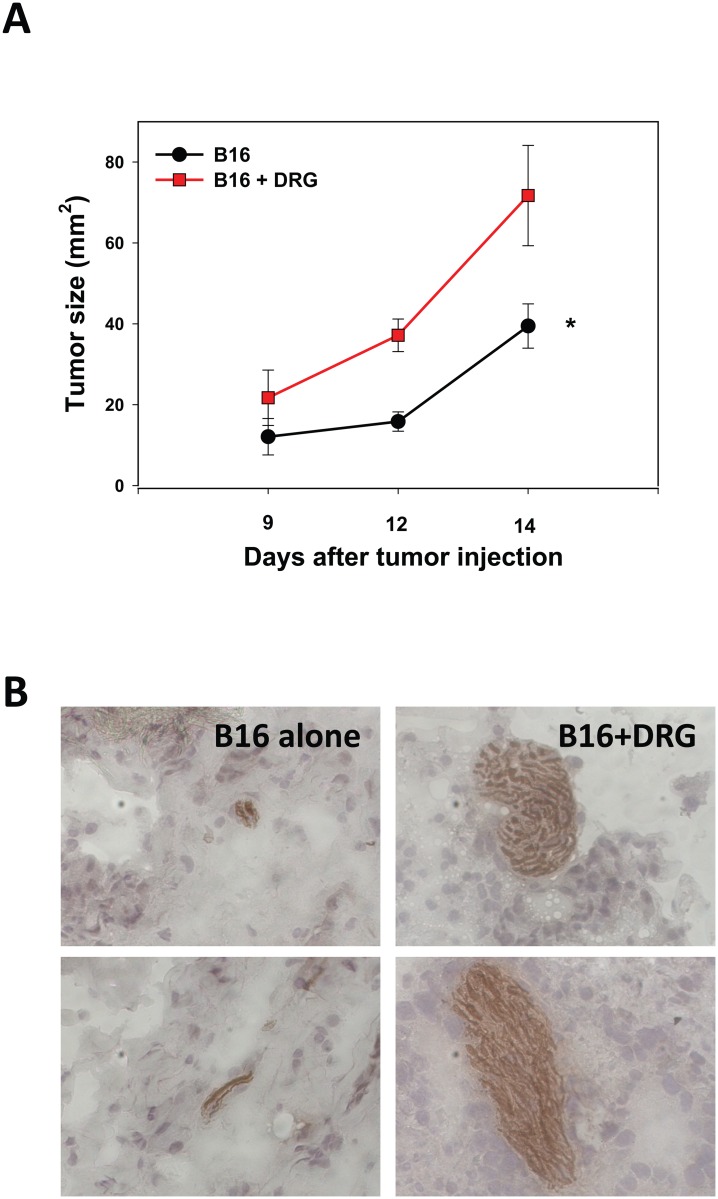
Co-administration of DRG neurons with B16 melanoma cells up-regulated tumor growth in mice.C57BL/6 mice (5 mice/group) received s.c. injection of 50x103 tumor cells alone or mixed with cultured DRG neurons (1:5 cell:cell ratio). Tumor size was assessed using a caliper and expressed in mm2 (A). Administration of DRG cells alone, as expected, did not induce any tumor growth. Tumor tissues were harvested two weeks later, and the presence of live DRG neurons in the tumor was determined by DAB staining after 14 days using an antibody against the anti-Neurofilament H epitope (B). Left panels show control tumors (administration of B16 cell alone), right panels show tumors growing in mice receiving B16+DRG neurons injections. Tumor size is expressed as the mean ± SEM. *, p<0.05 (ANOVA, n = 3).